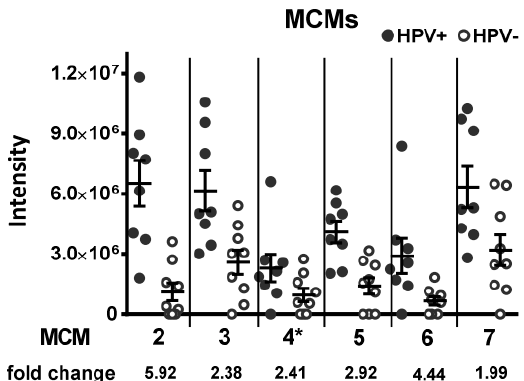
Figure 3. Expression of minichromosome maintenance proteins. All subunits of the MCM complex are, on average, expressed at a higher level in HPV-positive OPSCC, as assessed by LC–MS/MS intensity values. * not identified to be differentially expressed in our analyses.